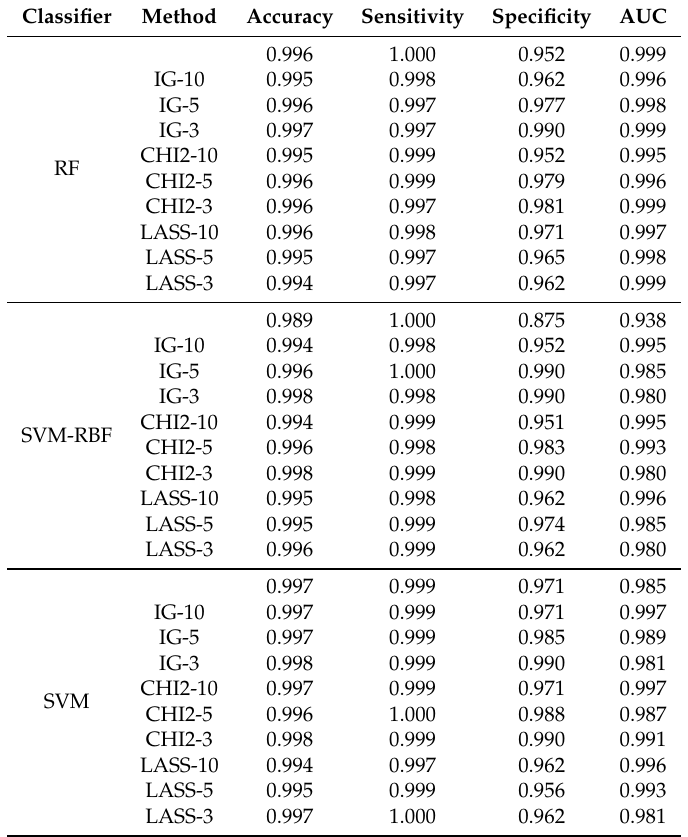
Table 2. Performance Metrics across different thresholds of miRNA Features (3, 5, 10).